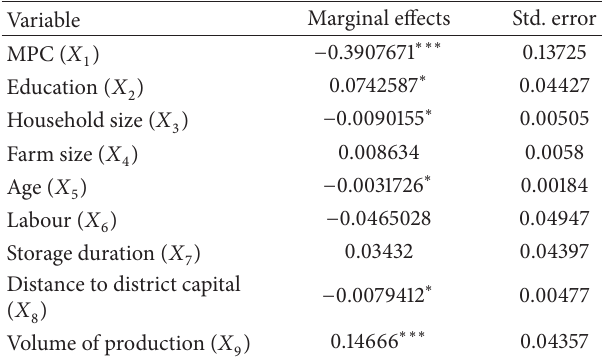
Table 4: Marginal effects from fractional logit regression (depen- dent variable is